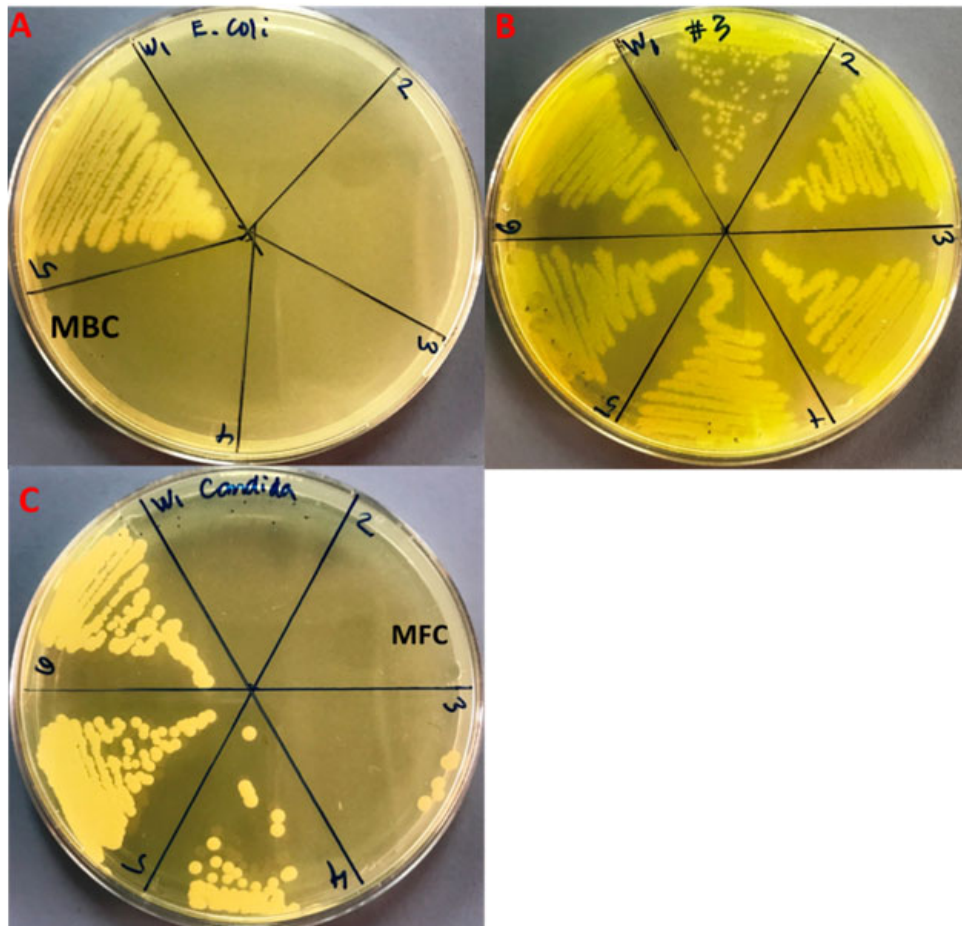
Table 4. MIC and MBC (mg/mL) values of Fenchone against tested pathogen.